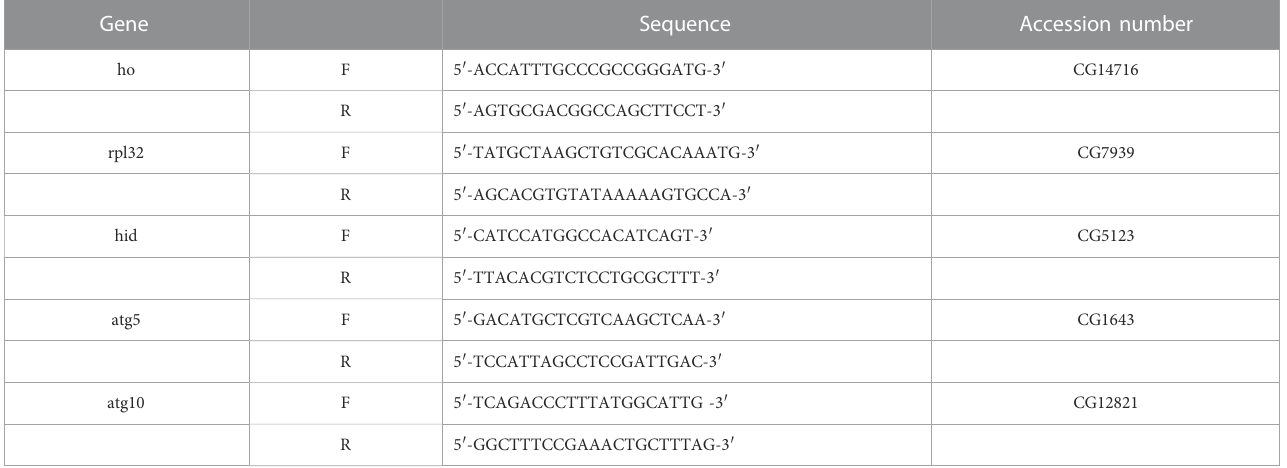
TABLE 1 Primer sequences of the genes which were used in this study. Gene